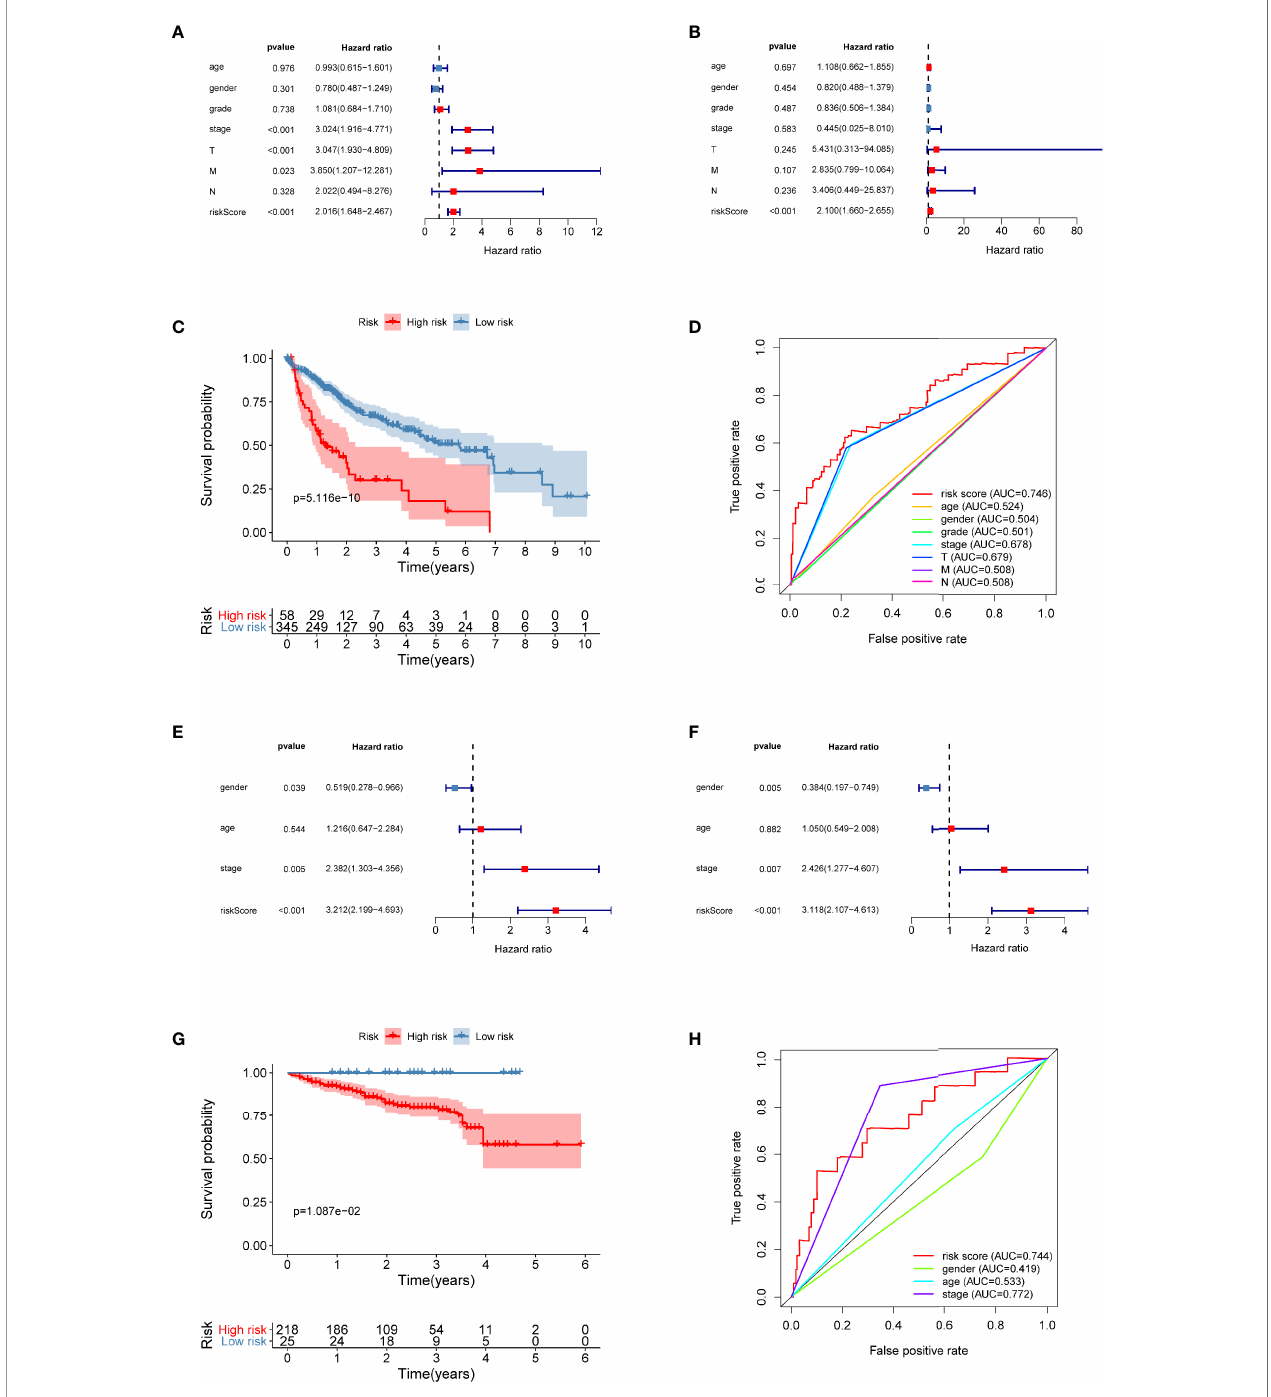
FIGURE 8 | The prognostic value of the fi ve-gene risk score for patients with liver cancer. (A, B) Univariate and multivariate Cox regression analyses revealed the independent value of the autophagy-related signature for overall survival (OS) of patients in TCGA database. (C) Kaplan – Meier (K – M) survival curve of OS of patients in the high-risk and low-risk patients based on TCGA database. (D) The time-dependent ROC curve analysis shows the AUC value for OS based on TCGA database. (E, F) Univariate and multivariate Cox regression analyses veri fi ed the independent value of the autophagy-related signature for OS of patients in the ICGC database. (G) K – M survival curve of OS in high-risk and low-risk patients based on the ICGC database. (H) Time-dependent ROC curve analysis shows the AUC value for OS based on the ICGC